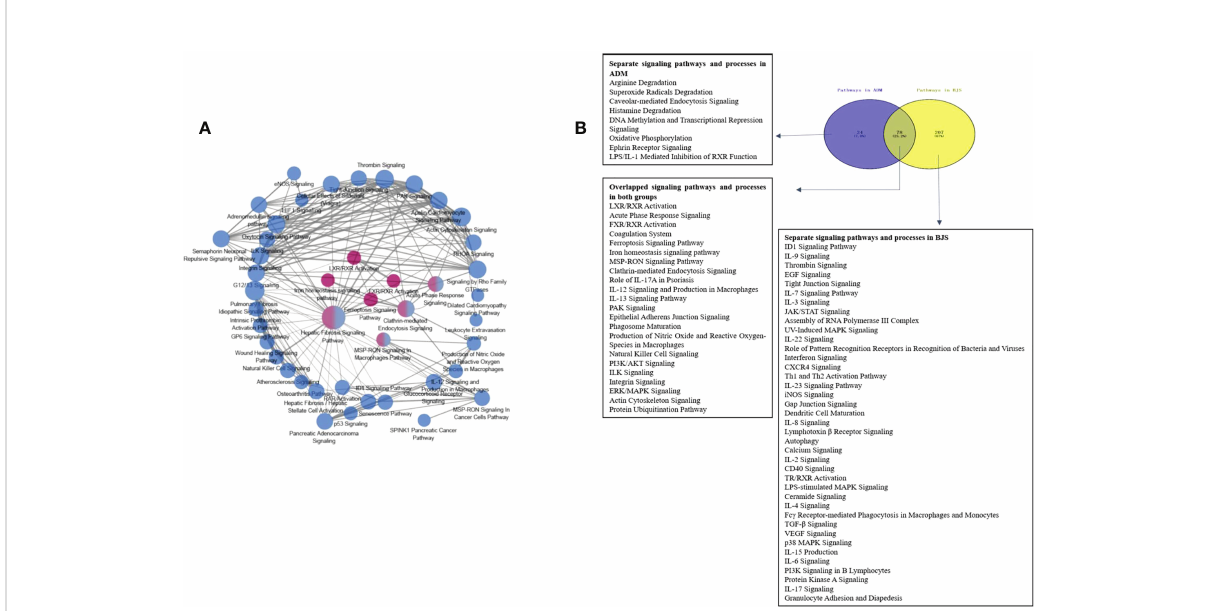
FIGURE 4 (A) Networks of enriched pathways. Nodes represent different pathways, and edges represent interrelation between pathways. Edge width corresponds to the score of a speci fi c pathway pair. The degree of a pathway was represented by node size. The red nodes represent the enriched pathway in the adalimumab group. The blue nodes are enriched in the secukinumab group. (B) Separate and overlapped pathways and processes in the two biological agent groups. A Venn diagram was used to screen the skin-related signalling pathways and processes obtained from IPA. The term “ ADM ” represents adalimumab, while “ BJS ” represents secukinumab in the